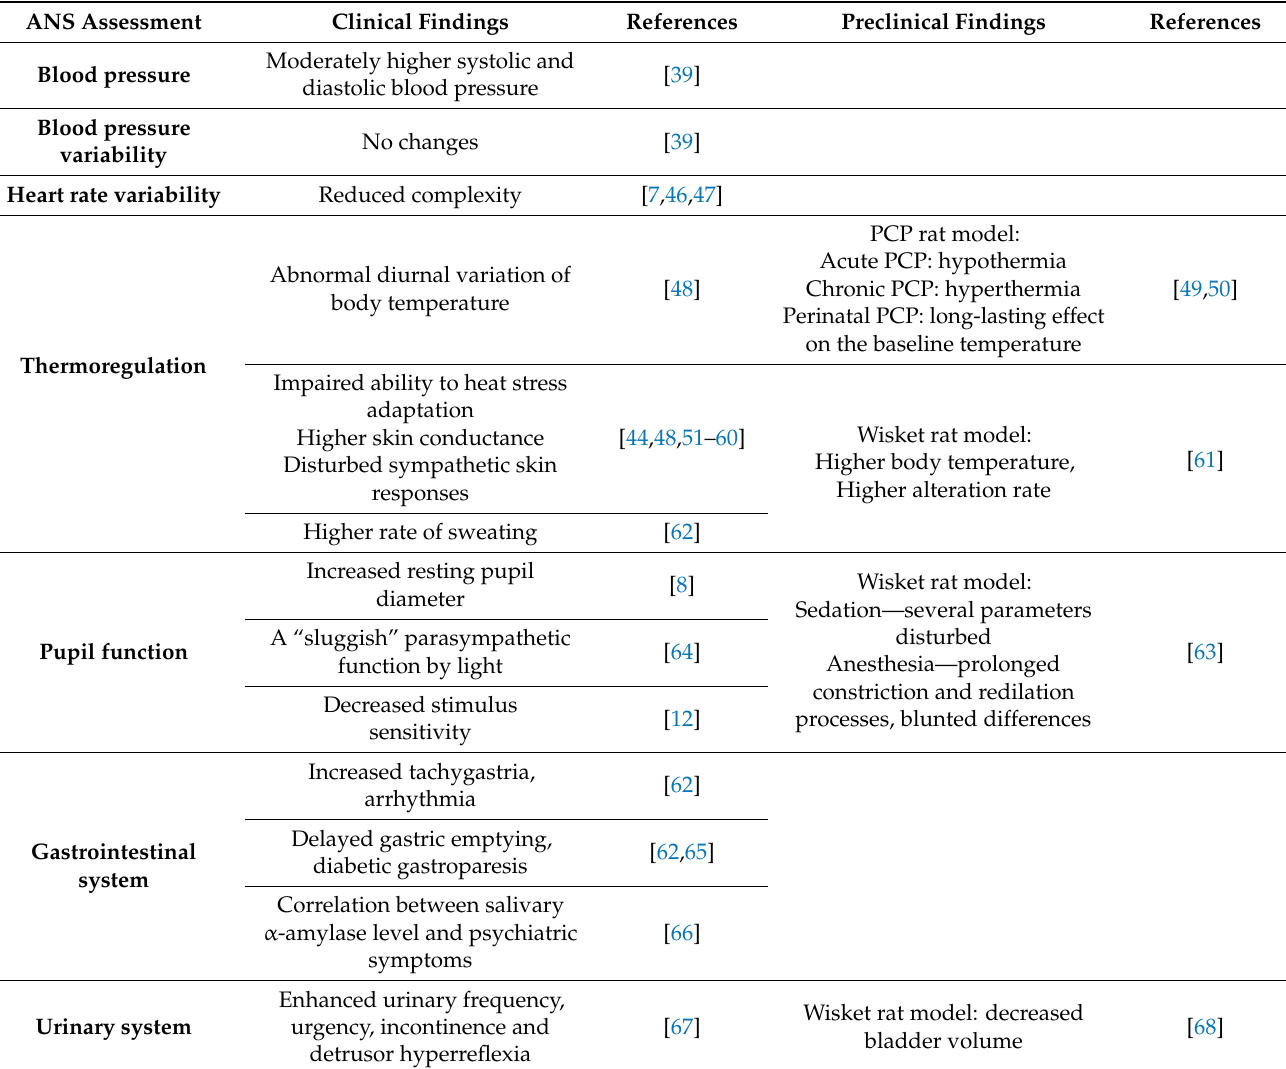
Table 1. Autonomic nervous system related clinical and preclinical findings in